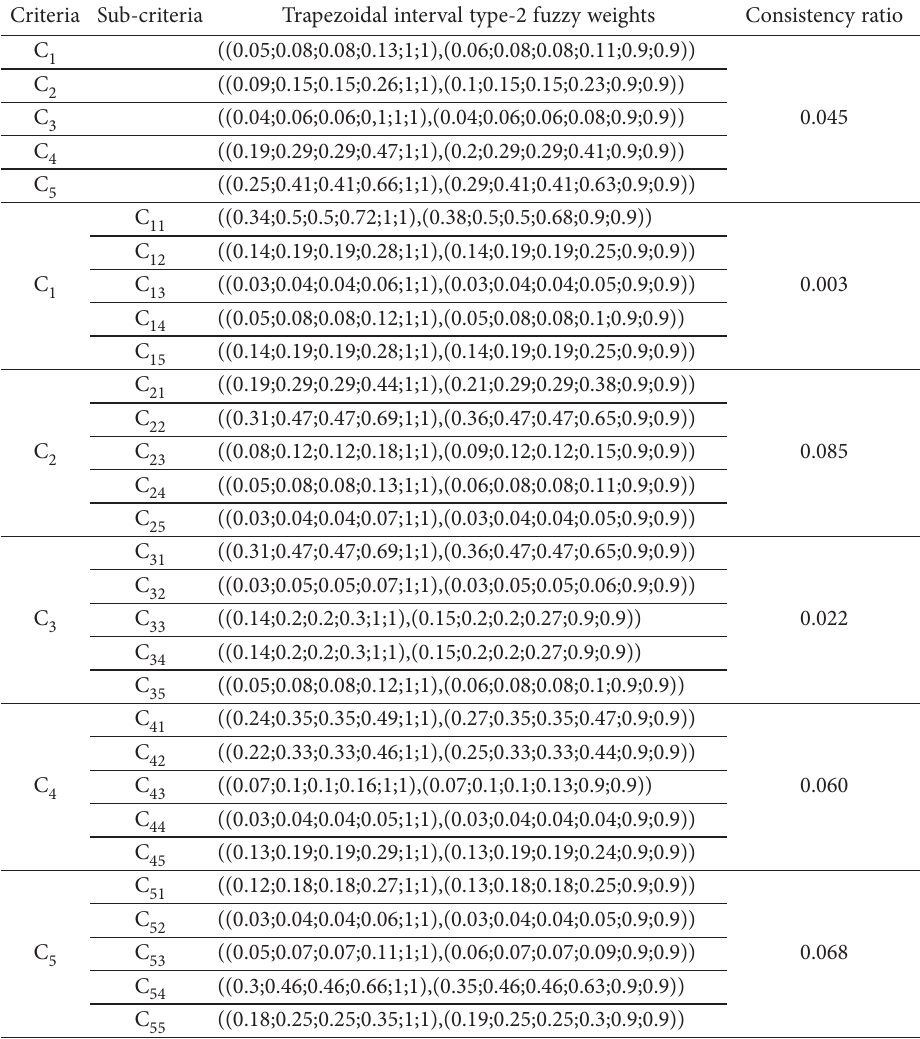
Table 4. Type-2 fuzzy weights obtained with TIT2FAHP Criteria Sub-criteria Trapezoidal interval type-2 fuzzy